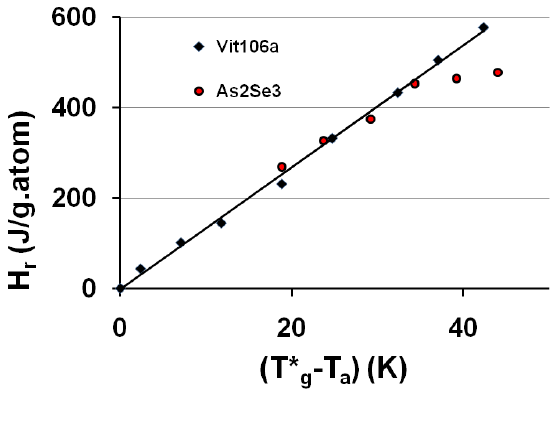
is plotted versus (T* r